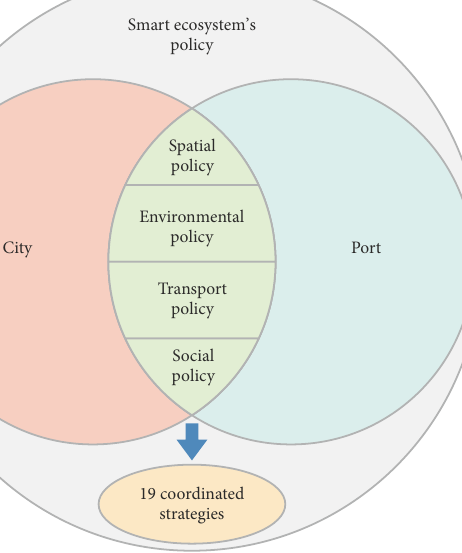
Figure 1. 4 pillars SCP policy for smart ecosystem development